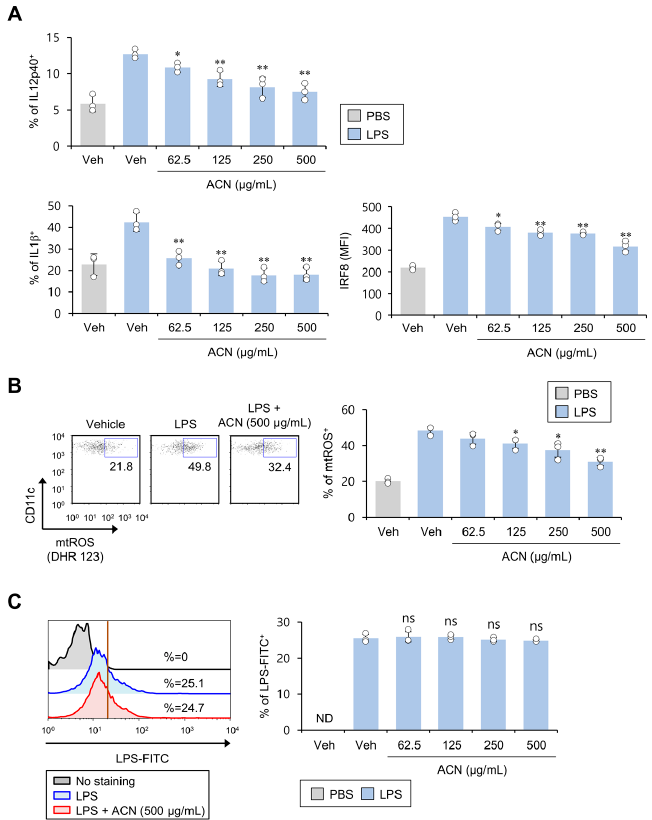
Figure 3. ACN treatment attenuates the pro-inflammatory response of DCs in response to in vitro LPS stimulation. ( A , B ) Splenic DCs were cultured for 16 h with ACNs (62.5, 125, 250, and 500 µ